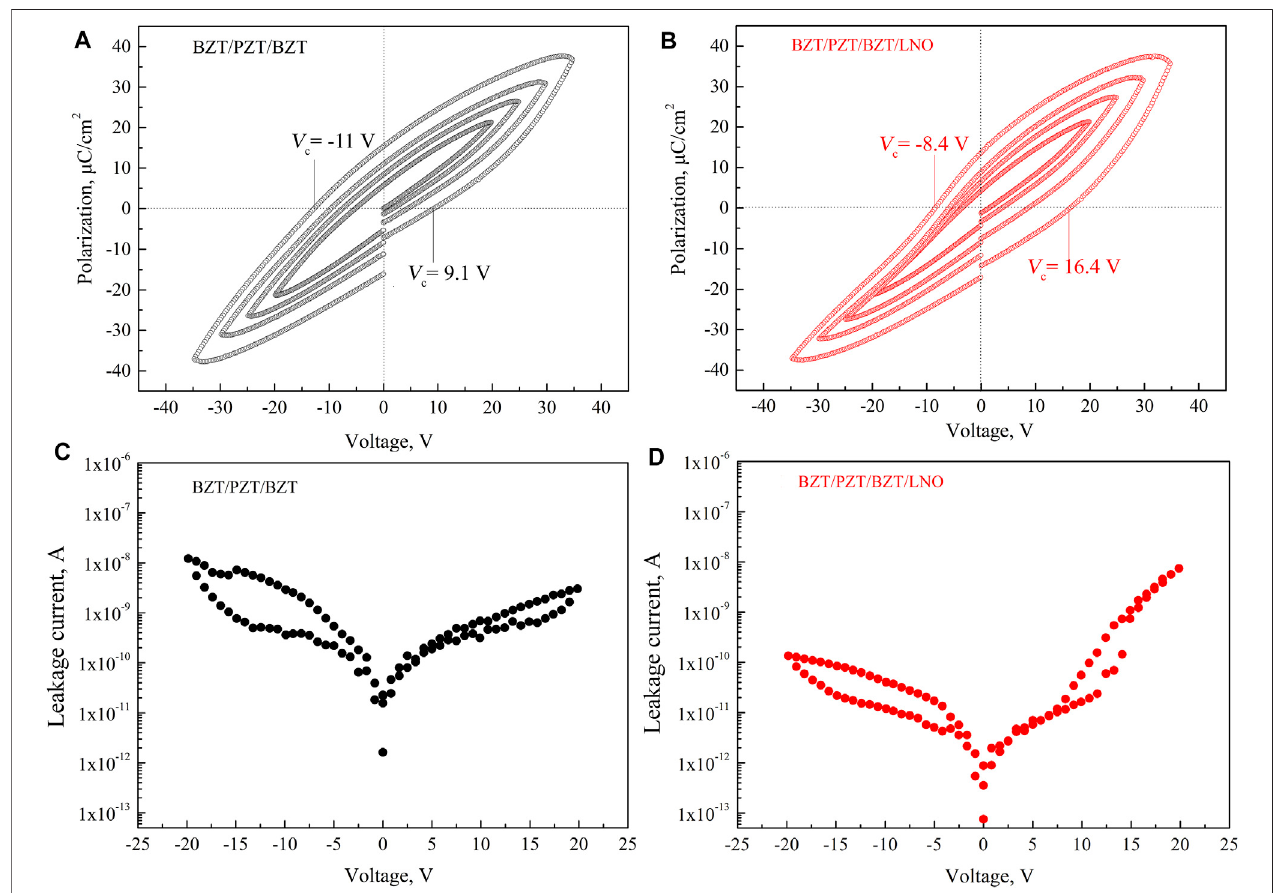
FIGURE 5 | Hysteresis loops and leakage current with different applied voltages. (A, C) BZT/PZT/BZT thin fi lms. (B, D) BZT/PZT/BZT/LNO thin fi lms.